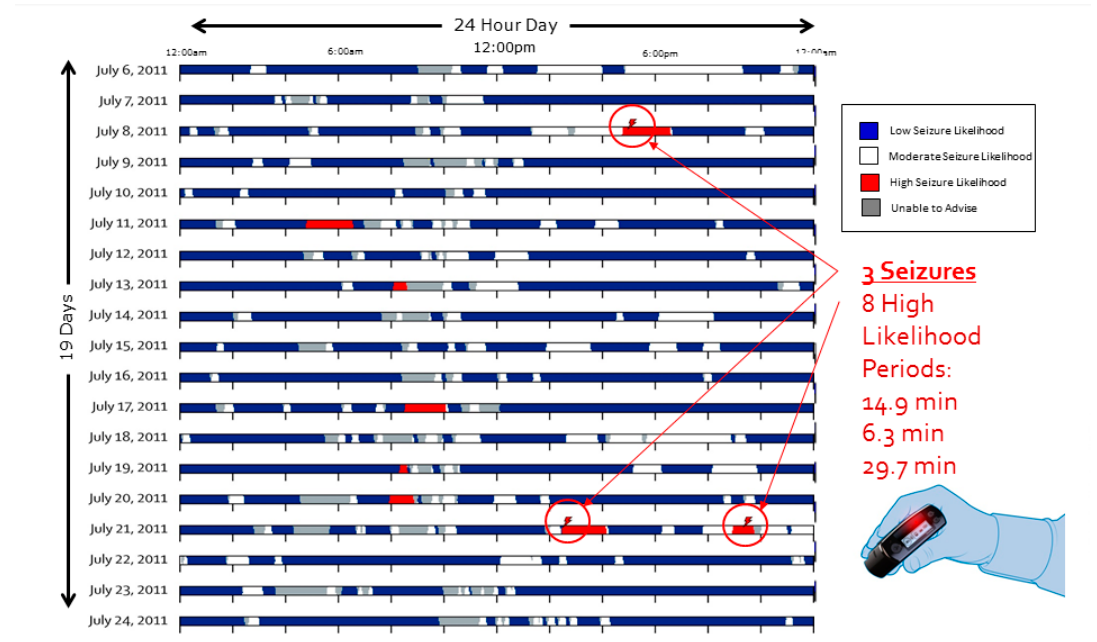
Figure 7. Advisory Timeline over 19 day contiguous block. Each of the 19 horizontal rows represents a continuous 24 h period. Each day-long row is a raster plot comprising columns of pixels, each column representing 2.3 min duration and comprising a vertical series of pixels, each pixel representing 13.8 s. In the Advisory Timeline block, the patient had three seizures, each of which occurred within a “High Likelihood” (red indicator) advisory, of which there were eight in this 19-day period. In chronological order, the seizure advisory advance warning times were 14.9, 6.3, and 29.7 min.